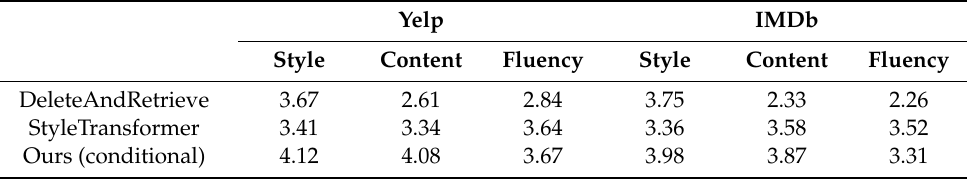
Table 3. The manual evaluation results of the Yelp and IMDb